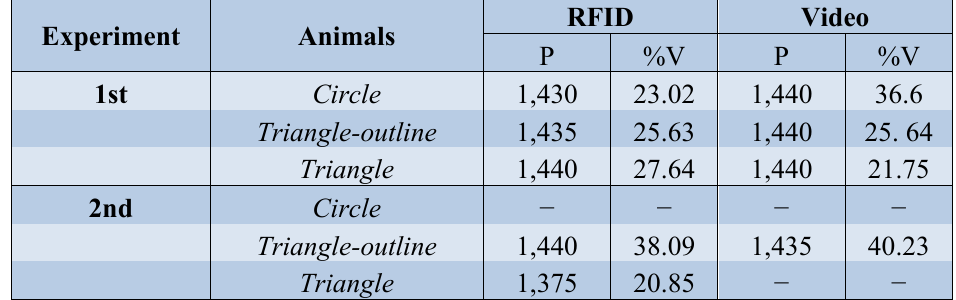
Table 3. Outputs of a periodogram analysis ( i.e. , the periodicity P in min and the percentage of variance V%, as a measure of the strength of detected rhythms) of the time series of locomotion data for three Nephrops held together in a microcosm tank, obtained using RFID and automated video tracking during two consecutive laboratory experiments.